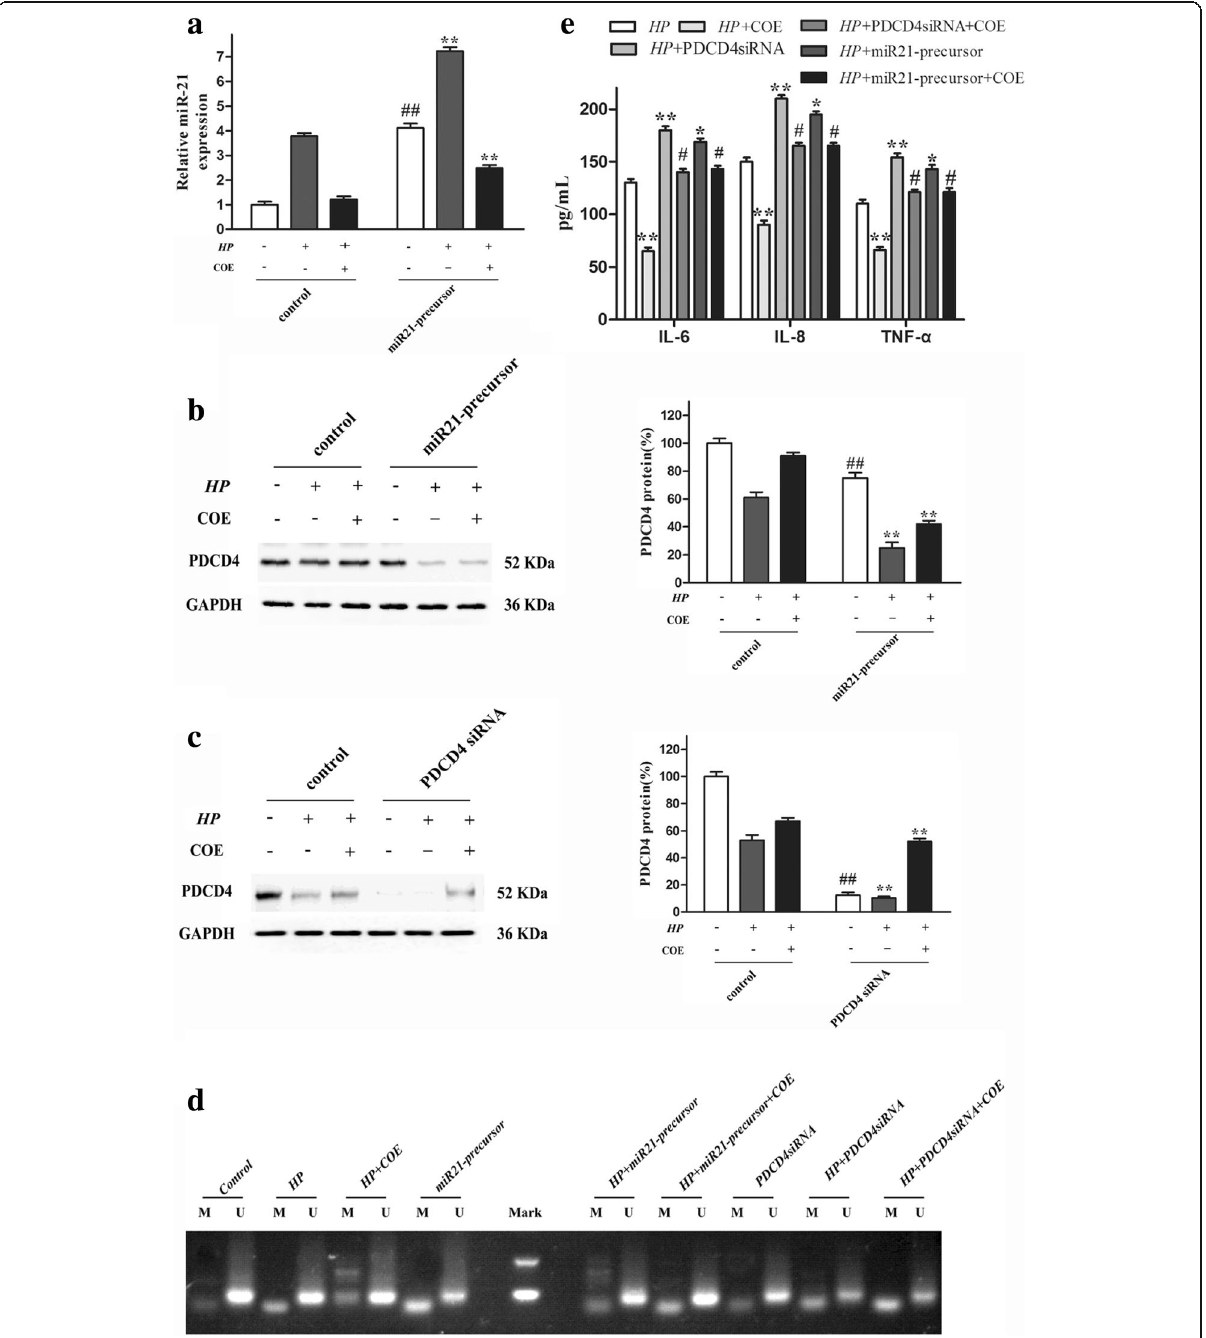
Fig. 6 Over-expression of miR-21 and knockdown of PDCD4 impairs the anti-inflammatory effect of COE. GES-1 cells were pre-transfected with miR-21 precursor, PDCD4 siRNA and then exposed to COE for 24 h. ( a ) The relative miR-21 level was determined by RT-PCR. ( b - c ) Cell lysates were prepared to determine the protein level of PDCD4 using western blot analysis. The expression of PDCD4 was determined by western blot. ( d ) The MSP assay was performed to evaluate the correlation between the PDCD4 methylation status. ( e ) The anti-inflammatory effect of COE was determined by testing the levels of IL-6, IL-8 and TNF- α . Data are presented as mean ± SD of three separate experiments, * P < 0.05, ** P < 0.01, compared to H. pylori infection-induced group, # P < 0.05, ## P < 0.01, compared to transfected with miR-21 precursor or PDCD4 siRNA